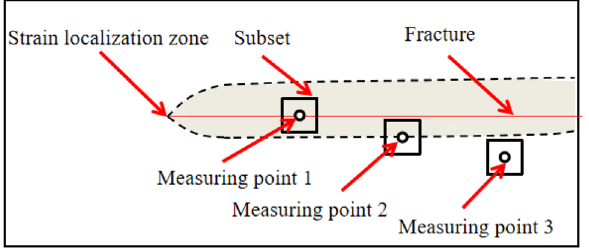
Figure 2. Diagram of deformation around fracture measured by